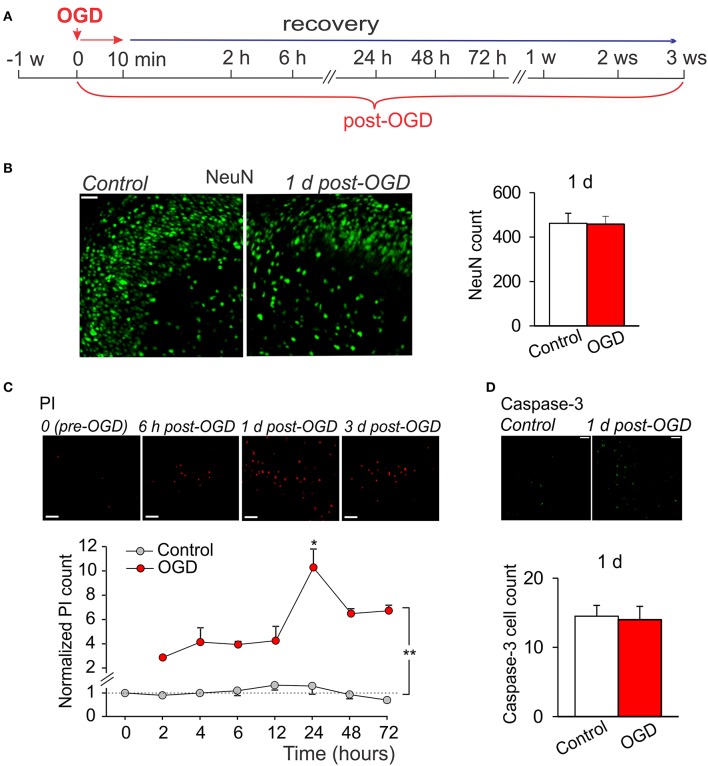
Mild OGD produces little acute effects on CA1 morphology. (A) Cartoon of an experimental modeling of mild OGD (10-min duration) in organotypic hippocampal slice cultures, showing time-scale for the assessments of acute, and delayed CA1 neuronal damage. (B) Immunohistology with the neuronal marker, NeuN (left images), and quantitative analysis of the NeuN-positive cells in CA1 area (right graphs) in control (n = 5 slices) and 1 d after induction of mild OGD (n = 13 slices exposed to 10-min OGD) demonstrate no acute changes between experimental groups. Data are mean with s.e.m. (C) Images of propidium iodide (PI) uptake in CA1 area in a slices exposed to mild OGD (upper raw) and the time course of changes in average number of PI-positive cells in control (n = 4 slices) and after mild OGD (n = 4 slices exposed to 10-min OGD; bottom). The number of PI-positive cells is normalized to control value (“0” time-point, before induction of OGD). **P < 0.01 (unpaired t-test compared with the corresponding control). (D) Immunohistology with caspase-3 in CA1 area (top raw) and average number of the caspase-3-positive cells in control (n = 4 slices) and 1 d after mild OGD (n = 11 slices exposed to 10-min OGD) demonstrate no difference between groups (bottom). Scale bar, 50 μm for all panels. Data are mean with s.e.m.